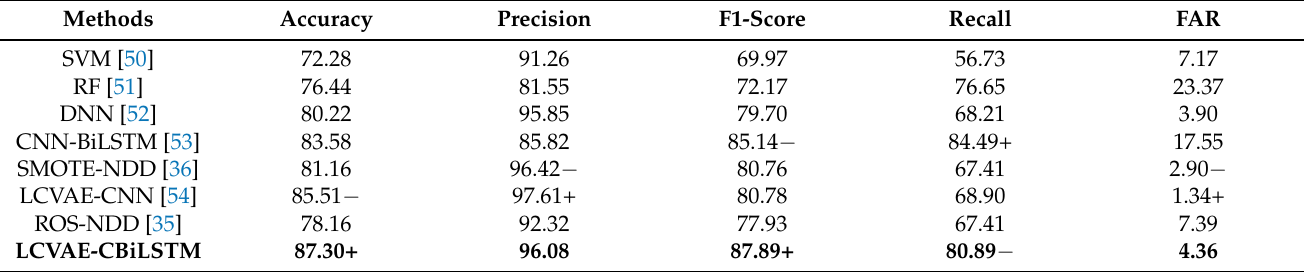
Table 5. Comparison results (%) of different detection models on the KDDTest+